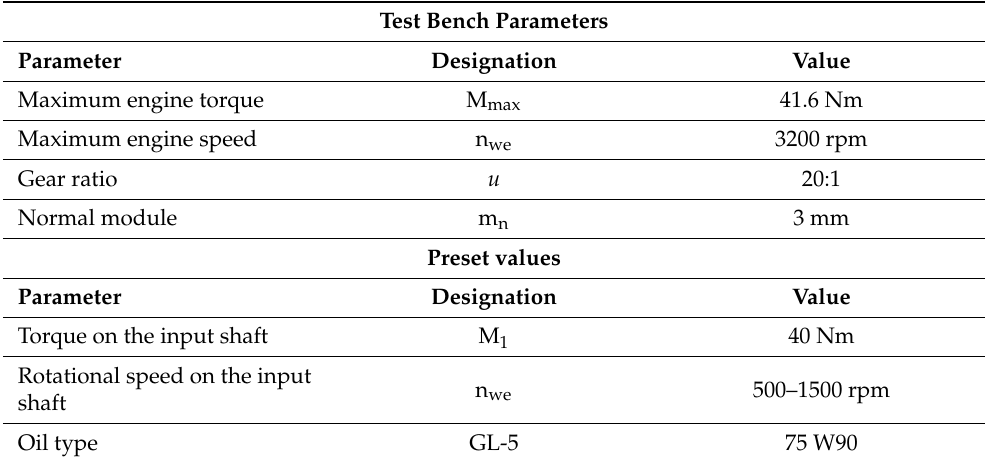
Table 2. Basic operational parameters of the tested spiroid gear.